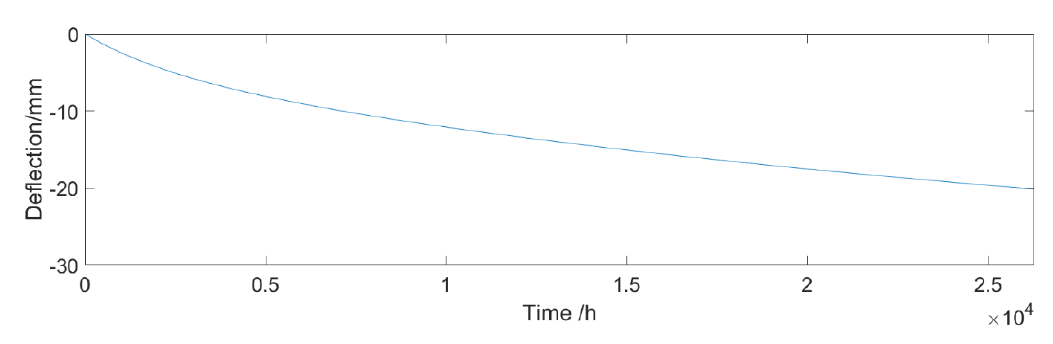
Figure 8. Deflection effect of shrinkage and creep.